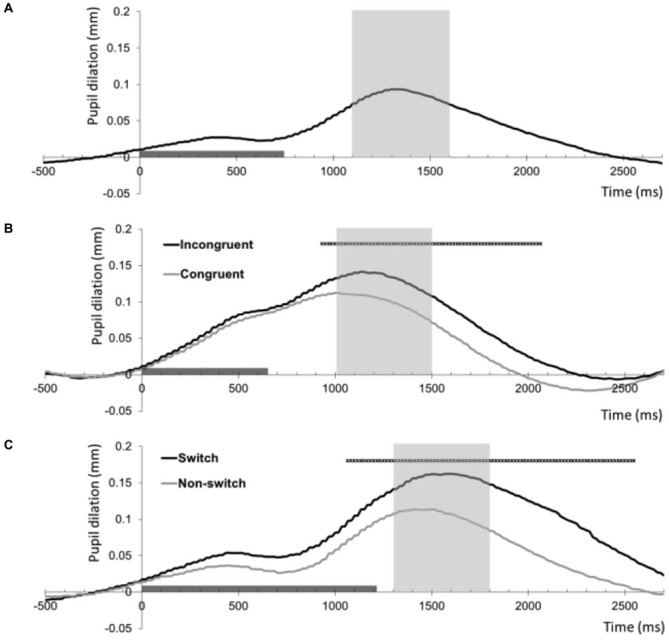
Baseline-corrected pupil dilation (mm) averaged across all 35 participants for the three tasks as a function of time (ms). The timeline marker indicates the presentation of the imperative stimulus (stimulus offset shows the mean reaction time across participants). The shaded area around the peak shows the interval that was used as summary measure of mean pupil dilation. (A) Pupil dilation relative to the onset of target trials of the 2-Back task. (B) Pupil dilation relative to the onset of correct congruent and incongruent trials of the Stroop task. The black straight line indicates samples with a significant difference between these conditions (thresholded at p < 0.001, >5 contiguous samples). (C) Pupil dilation relative to the onset of correct non-switch and switch trials of the Number Switch task. The black straight line indicates samples with a significant difference between these conditions (thresholded at p < 0.001, >5 contiguous samples).